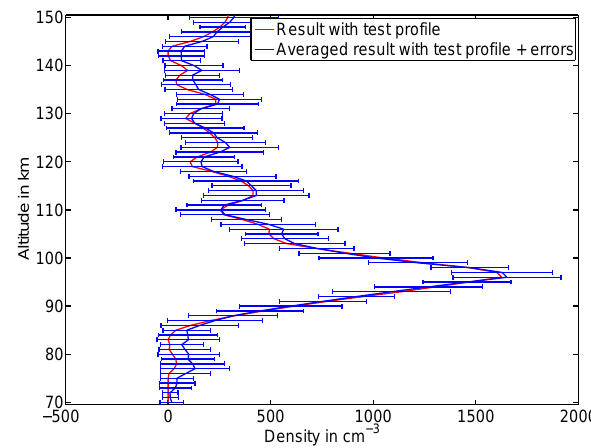
Fig. 23. Mg + (280.4nm) retrieval result. The same methods as in Fig. 21 are applied. The errors for Mg + are smaller than for Mg and furthermore nonlinear self-absorption effects are smaller for Mg + . Therefore, both methods lead to the same mean results.